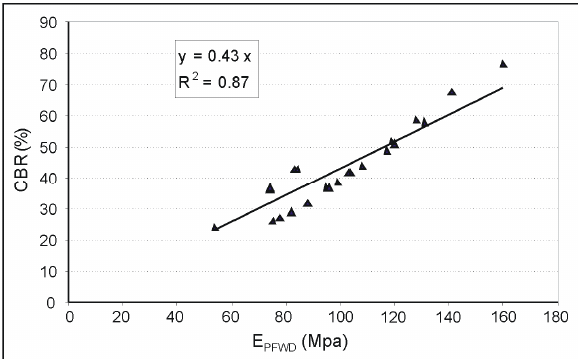
Fig. 6. A zero intercept regression analysis between CBR and E PFWD